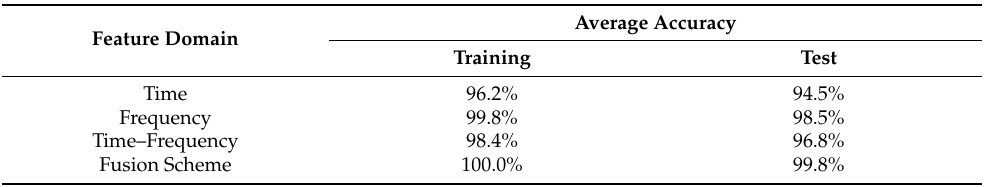
Figure 13. Feature visualization via t-SNE for: ( a ) time domain, ( b ) frequency domain ( c ) time–frequency domain and ( d ) fusion scheme. The colors used to represent the clusters shown in the resulting projections belong to the NC ( ● ), BF ( ● ), IF ( ● ) and OF ( ● ) conditions, where the different load conditions for each bearing condition are represented by the markers △ , + , ○ and * , respectively. Table 10. Resulting classification ratios through the SoftMax layer for the particular evaluation of each feature domain and the proposed fusion scheme.